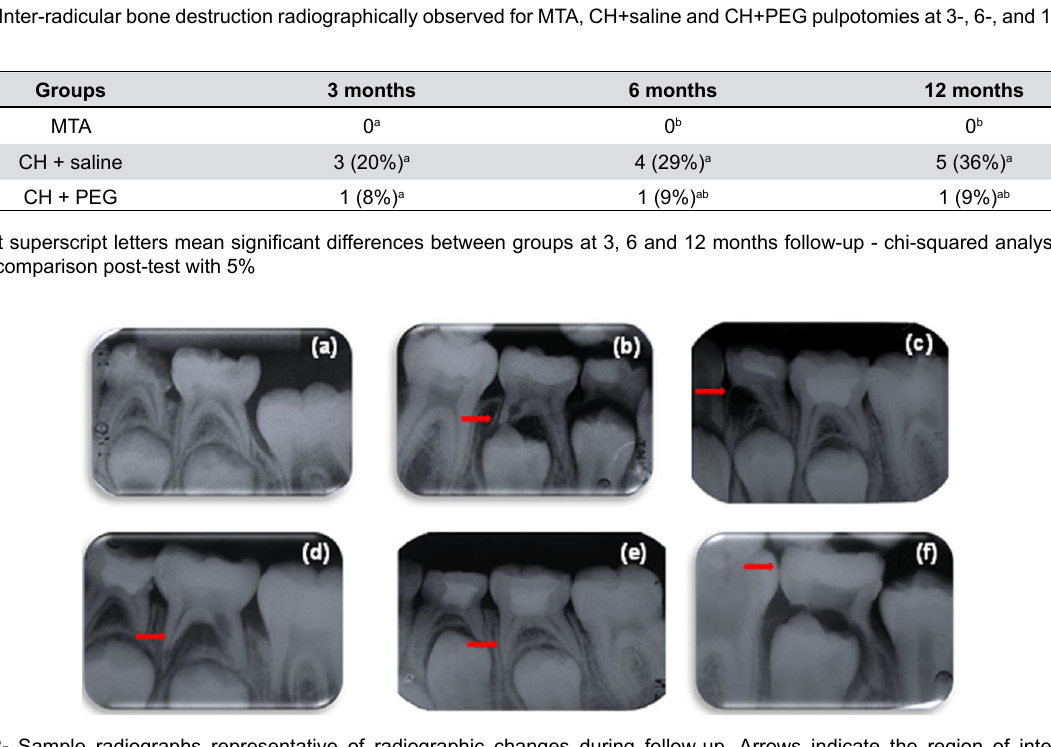
Figure 2- Sample radiographs representative of radiographic changes during follow-up. Arrows indicate the region of interest. (a) Preoperative radiograph; (b) Internal root resorption without perforation; (c) Internal root resorption with perforation; (d) Inter-radicular bone destructions; (e) Radiographic success; (f) Tooth too close to